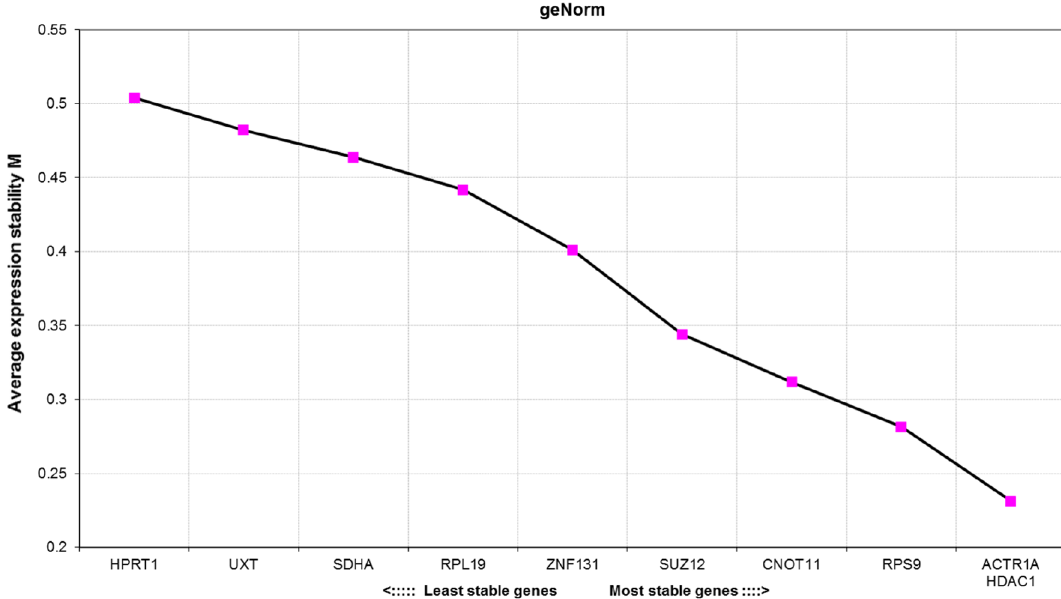
Figure 1. Average expression stability M of candidate reference genes calculated by the geNorm algorithm. The lower the M value, the more stably is the gene expressed in the tested